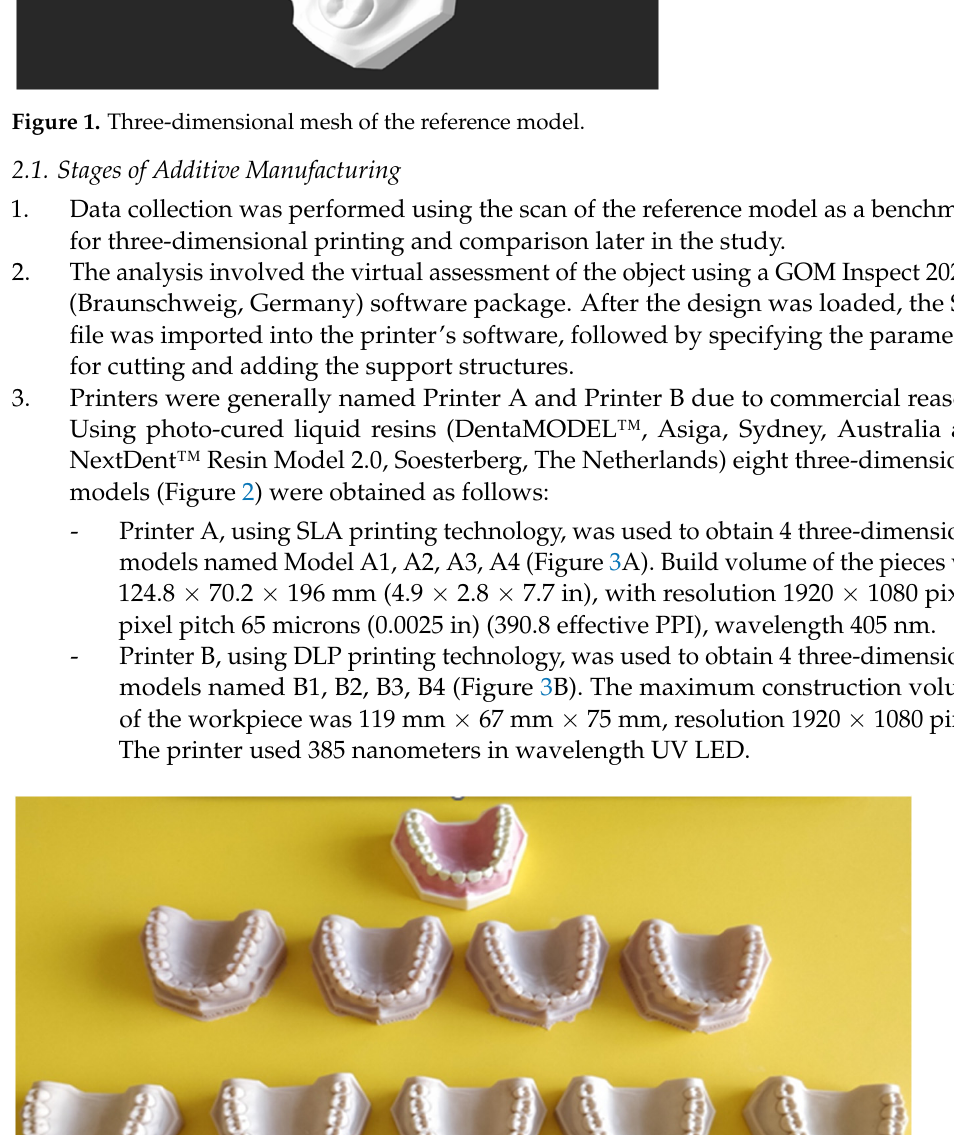
Figure 1. Three-dimensional mesh of the reference model.